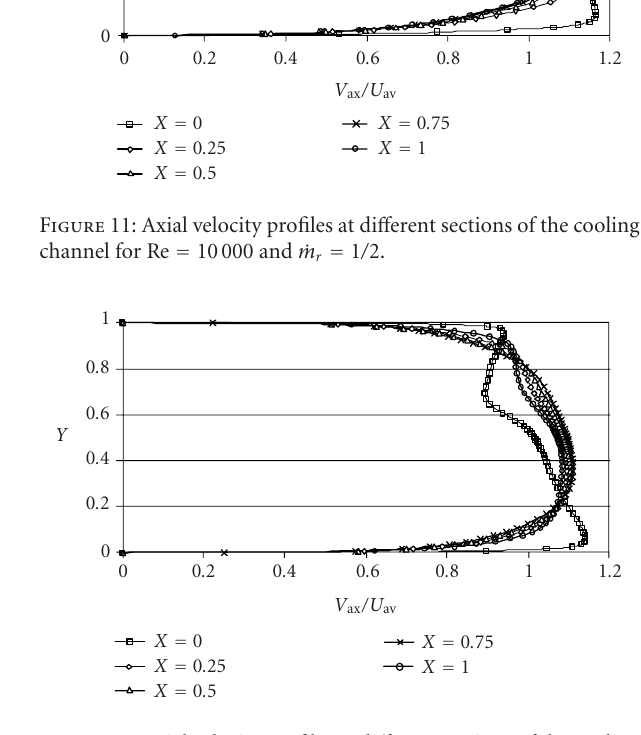
Figure 12: Axial velocity profiles at di ff erent sections of the cooling channel for Re = 50000 and ˙ m r = 1 /